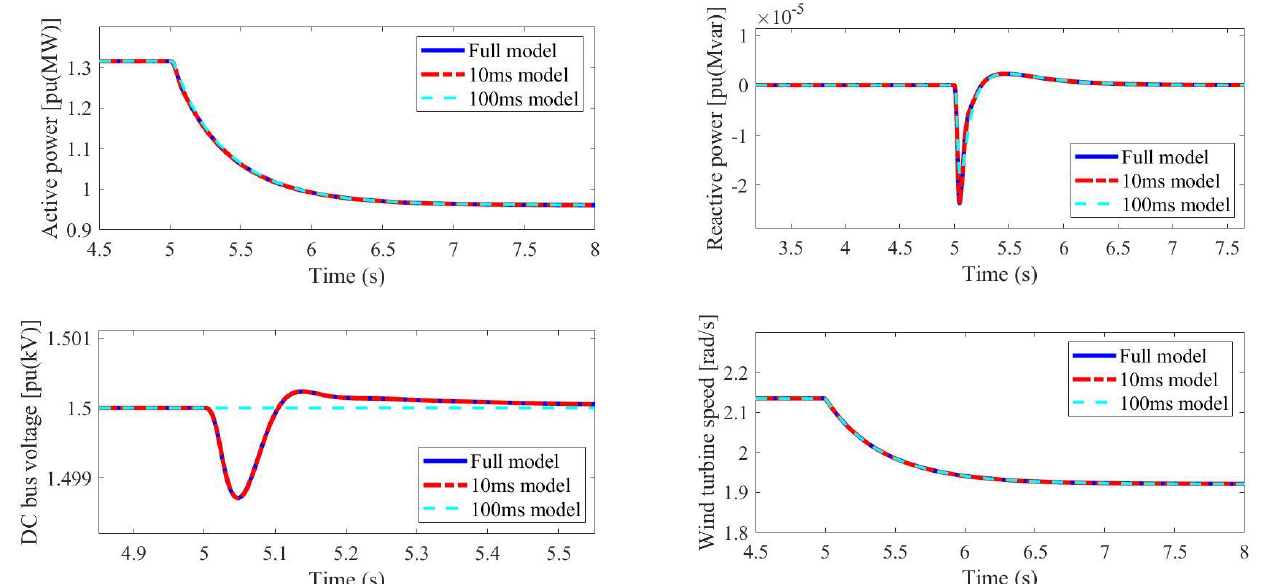
Figure 9. Variable wind speed: timescale model comparison.